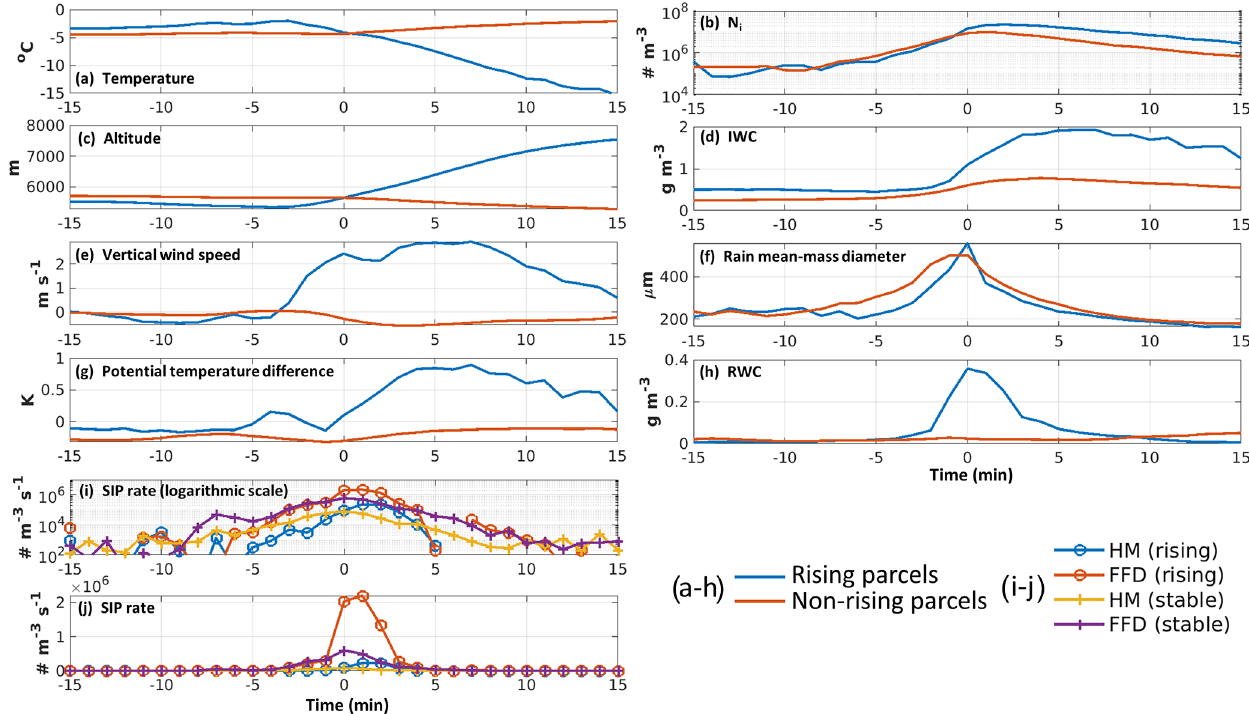
Figure 18. Trajectory tracing of different variables for the rising parcels (blue lines in a–h ) and the non-rising parcels (red lines in a–h ) for (a) temperature, (b) N i , (c) altitude, (d) IWC, (e) vertical wind speed, (f) rain mean-mass diameter, (g) (cid:49)θ , (h) RWC, (i) SIP tendency in logarithmic scale, and (j) SIP tendency in regular scale.